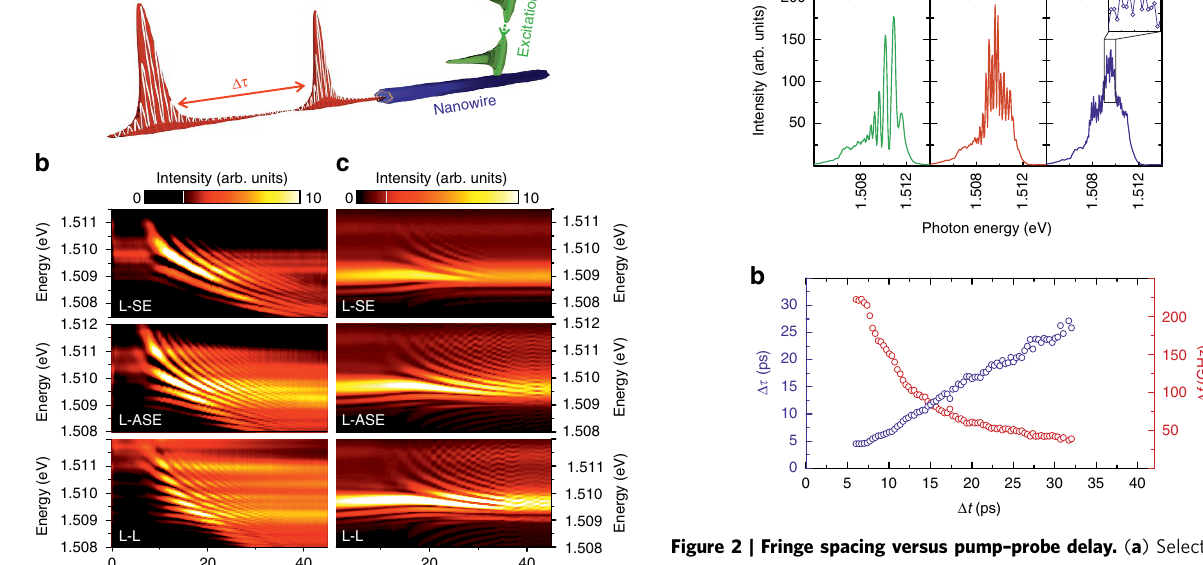
The duration of the first NW laser pulse emitted, represented by the white line at the bottom of Fig. 3b, is measured to be t pulse ¼ 0.9 ± 0.1 ps, whereas the second pulse induced by the probe pulse has a duration ranging from t pulse ¼ 3.7 ps ( D t ¼ þ 15 ps) to 1.6 ps ( D t ¼ þ 30 ps). Therefore, the analysis in the time domain is in good agreement with the results obtained from the analysis of the two-pulse interference in the frequency domain where similar pulse durations of t pulse o 5 ps, corresponding to a 200 GHz fringe separation, were observed. NATURE COMMUNICATIONS|8:15521|DOI: